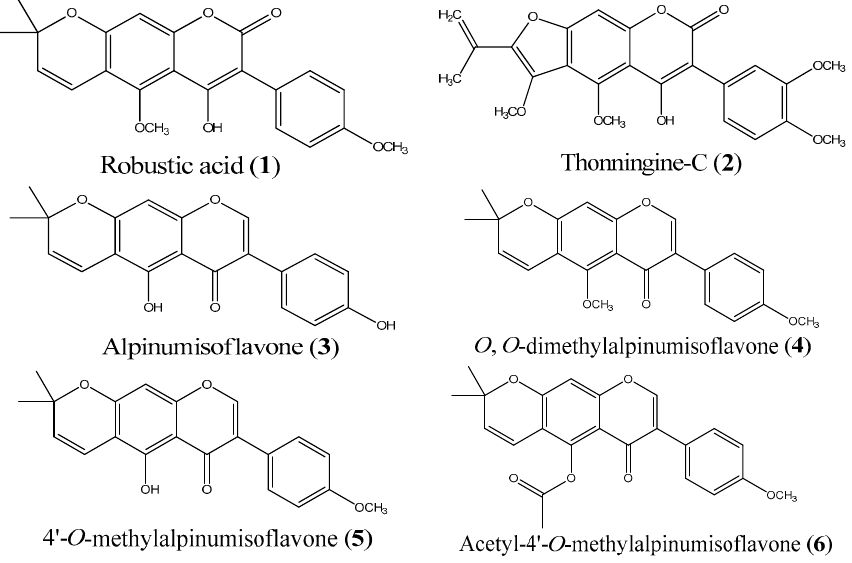
Figure 1. Structures of isolated coumarins ( 1 , 2 ) and isoflavanones ( 3 , 4 , 5 ) from M. thonningii and a synthesised derivative ( 6 ).